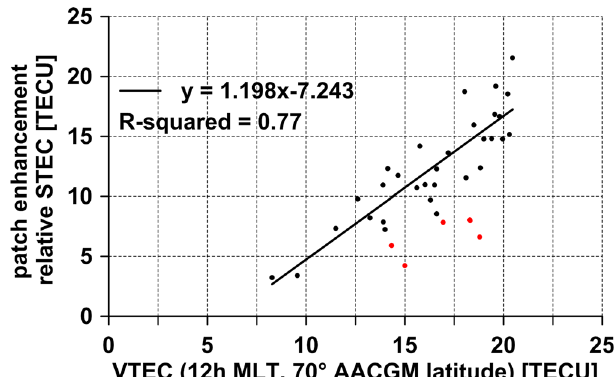
Fig. 11. The dependence of STEC patch enhancement on dayside VTEC. Black dots – results for 15 – 16 March and its linear approx- imation, red dots – structures observed for positive IMF Bz